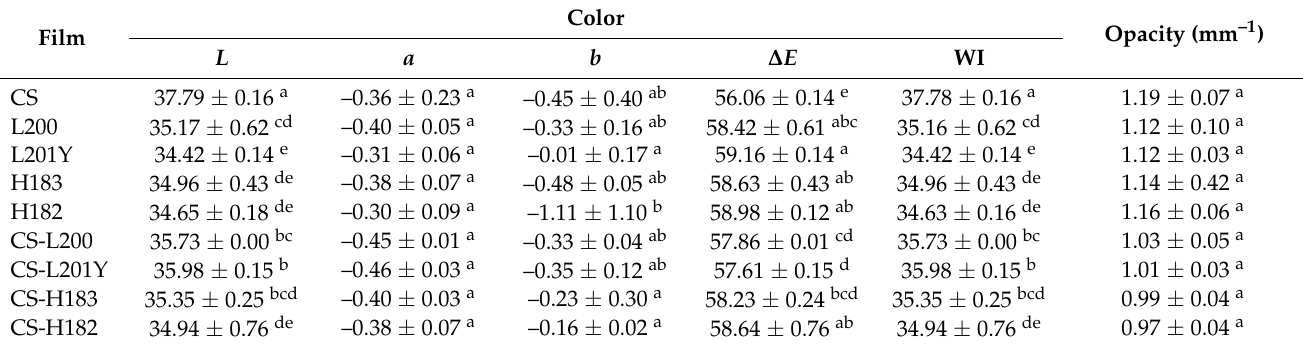
Table 2. Color parameters ( L , a , b , ∆ E ) and opacity of different monolayer and bilayer